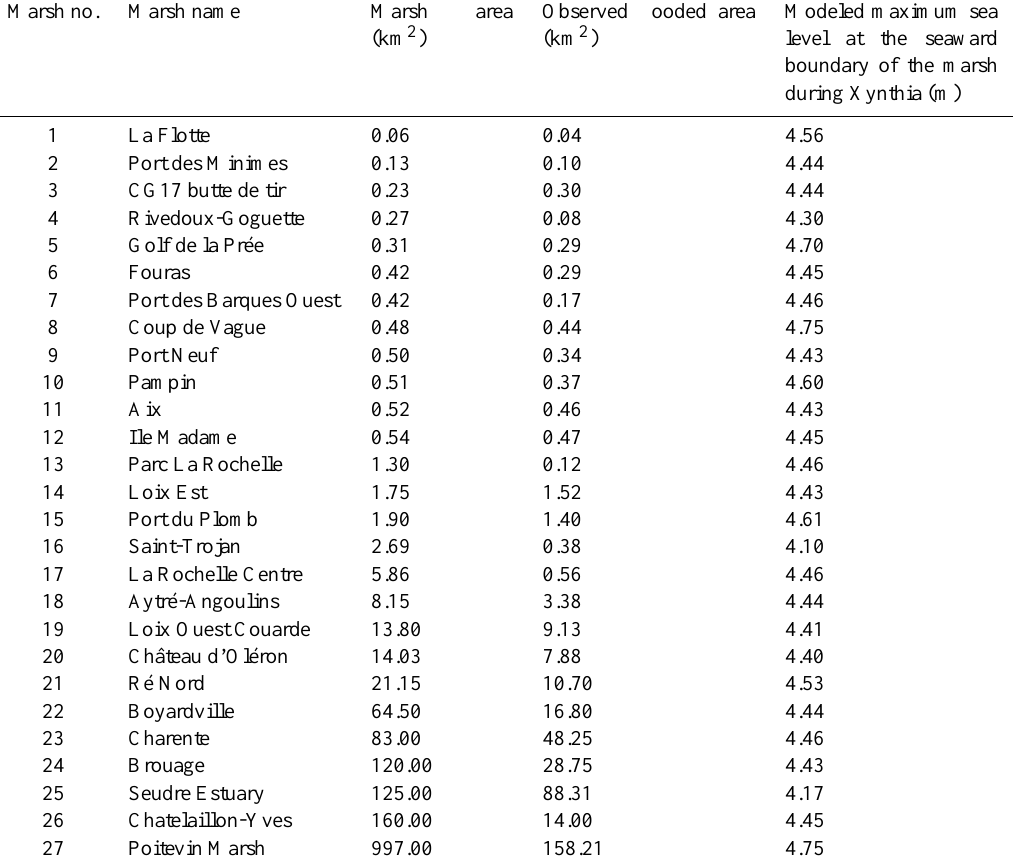
Table 3. The 27marshes of the study area classified according to size. Surface area of the flooded area during Xynthia and maximum sea level during this storm computed by the Bertin et al. (2012a) storm surge modeling system. Marsh